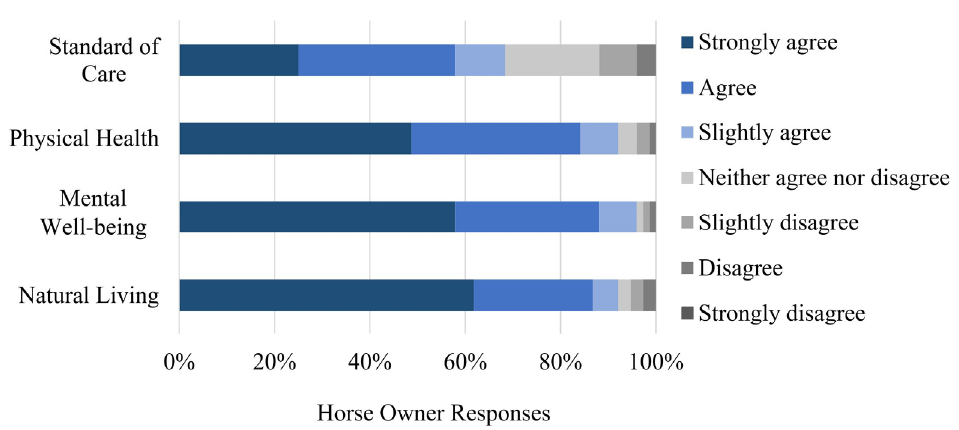
Figure 1. Owners’ level of agreement with horses’ welfare being better when housed outdoors ver- sus